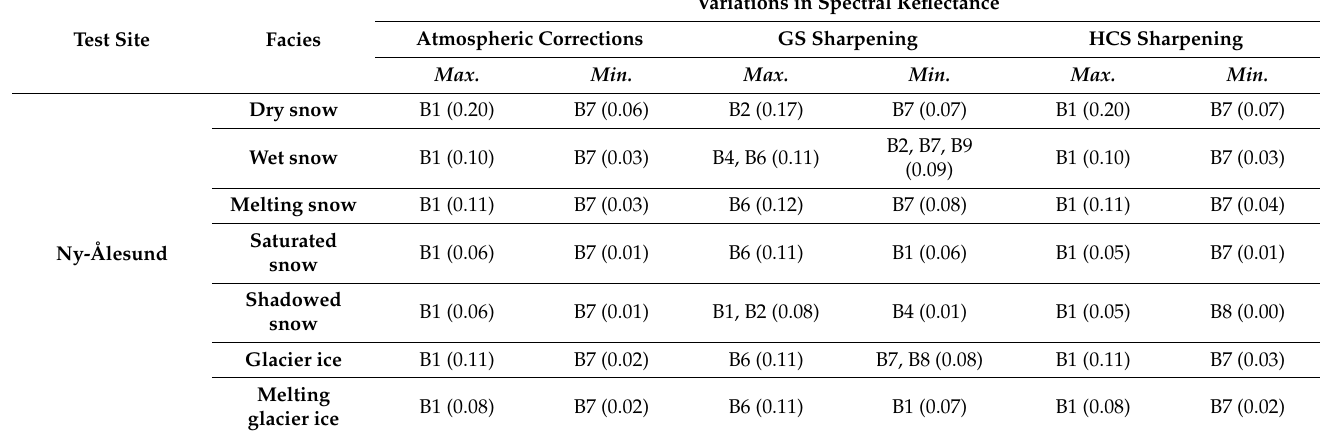
Table 6. Maximum and minimum variations in spectral reflectance of facies derived from the average spectral spectra from each processing scheme. Atmospheric corrections: calculated between DOS, FLAASH, and QUAC; GS sharpening: calculated between GS_DOS, GS_FLAASH, and GS_QUAC; HCS sharpening: calculated between HCS_DOS, HCS_FLAASH, and